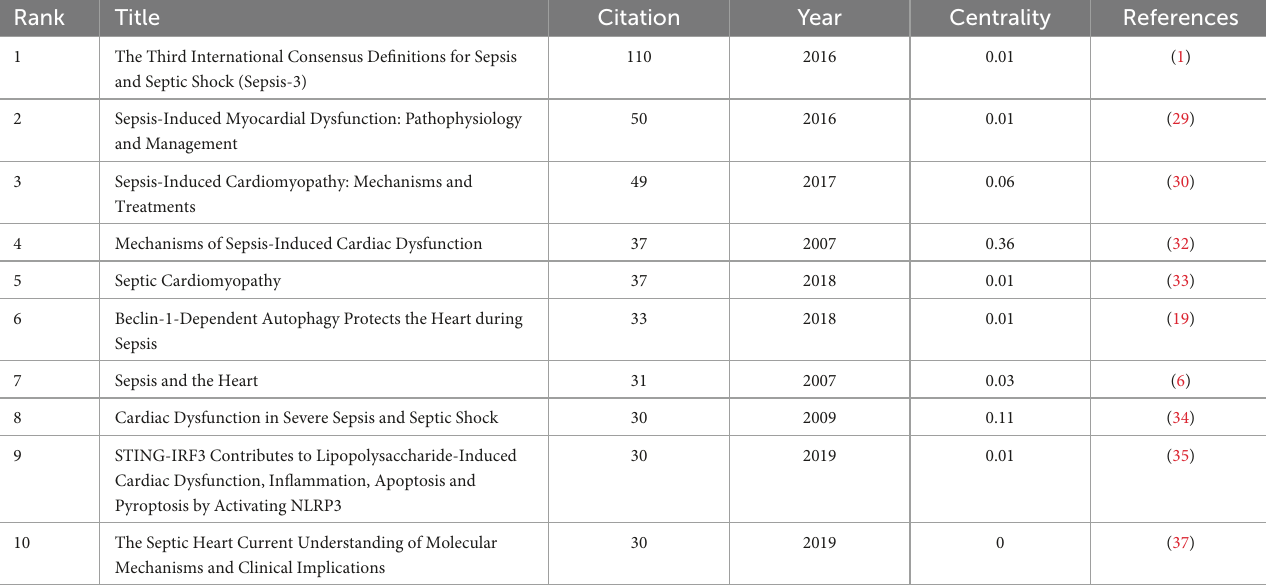
TABLE 4 Top 10 co-cited references related to